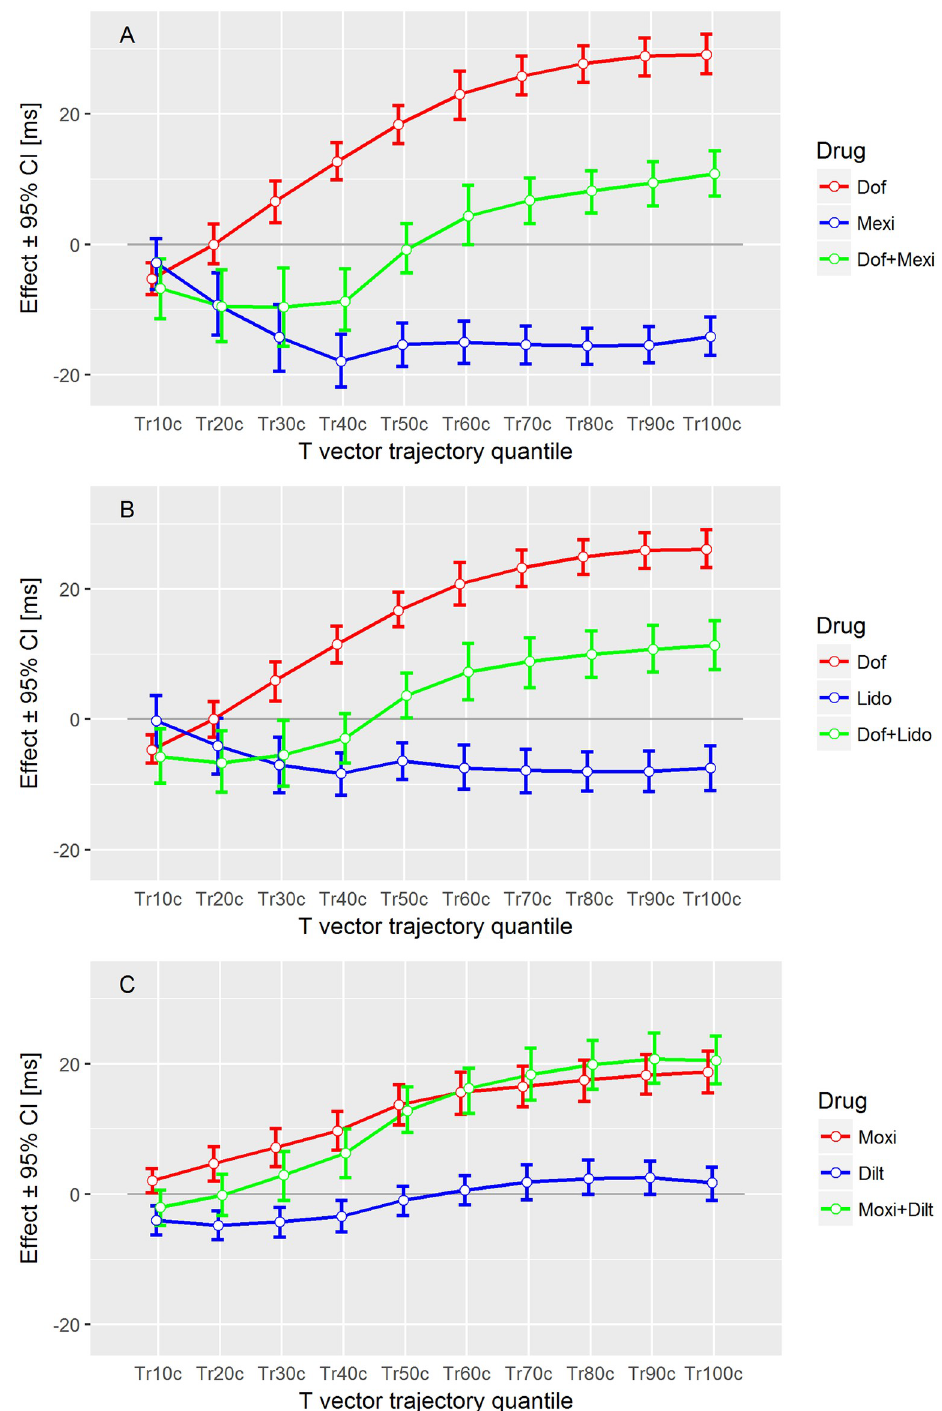
Fig 5. Drug effect profiles in Study B. The effect on the y-axis denotes the placebo-corrected changes from baseline of the T vector trajectory quantiles in milliseconds (corrected for heart rate) with their 95% confidence intervals at the drug concentrations as given in Table